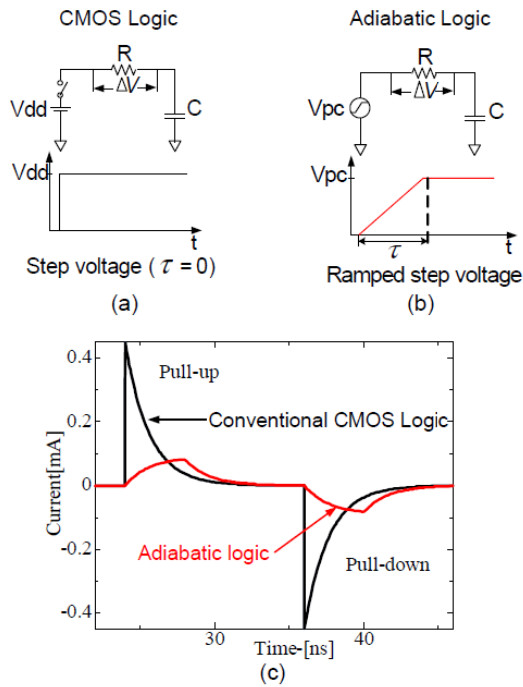
Figure 1. Comparison of the supply current transitions for the equivalent RC models of the ( a ) CMOS logic step voltage and ( b ) adiabatic logic ramped step voltage. ( c ) The peak supply current of the adiabatic logic is significantly lower than that of the conventional CMOS logic under the same parameters and conditions.